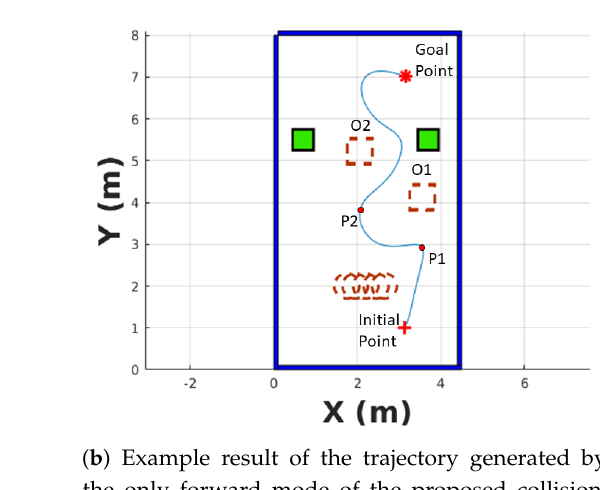
( a ) Gazebo environment used for the simulation experiments. Figure 5. Simulation experiments. In ( b ), the dotted line represents the moving obstacles and the solid line represents the static